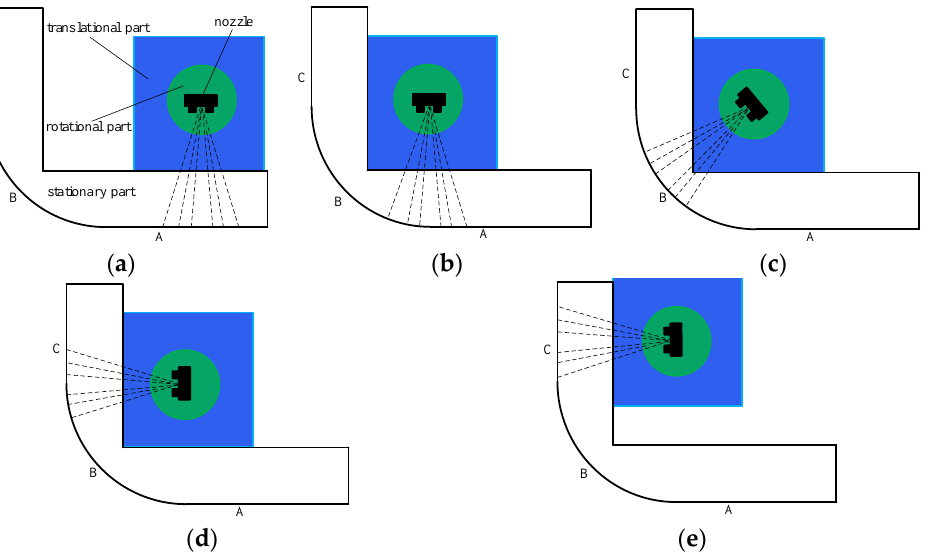
Figure 4. Sketches of the motions of different parts of computational domain during simulation when the nozzle moving to: ( a ) section A; ( b ) junction of sections A and B; ( c ) B section; ( d ) junction of sections B and C; ( e ) section C.